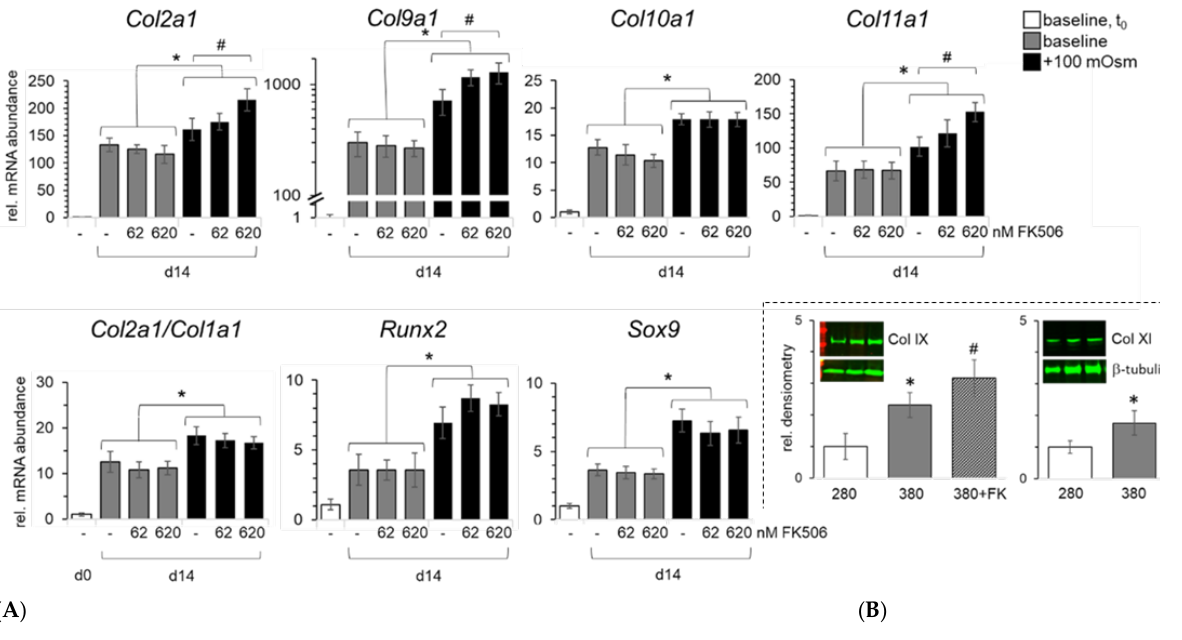
Figure 4. FK506 dose-dependently stimulates expression of fibrillar and minor collagens in physos- motic ATDC5 cultures. ( A ) Increased osmolarity enhances collagen mRNA expression, as well as key osteogenic ( Runx 2) and chondrogenic ( Sox 9) transcription factors, in ATDC5 cells. Addition of FK506 (62, 620 nM) dose-dependently increased mRNA abundance of Col2a1 , Col9a1 and Col11a1 even further, but not that of Col10a1 . Cells were cultured under plasma level osmolarity (i.e., baseline) and under physosmotic conditions (baseline +100 mOsm/kg; by addition of sterile sodium chloride from day 7 onwards). Shown are mRNA levels as quantified by RT-qPCR (n = 7), with a collagen type II vs. type I (i.e., Col2a1/Col1a1) expression ratio, next to expression of osteogenic ( Runx 2) and chondrogenic ( Sox 9) master regulators. Differences in osmolarity-related mRNA expression are indicated by * or by # for iso-osmotic FK506-specific differences, respectively. ( B ) Densitometrically determined differences in protein levels of collagen type IX (Col IX) and collagen type XI (Col XI), n = 3; β -tubulin (loading control); FK, 620 nM FK506; p <